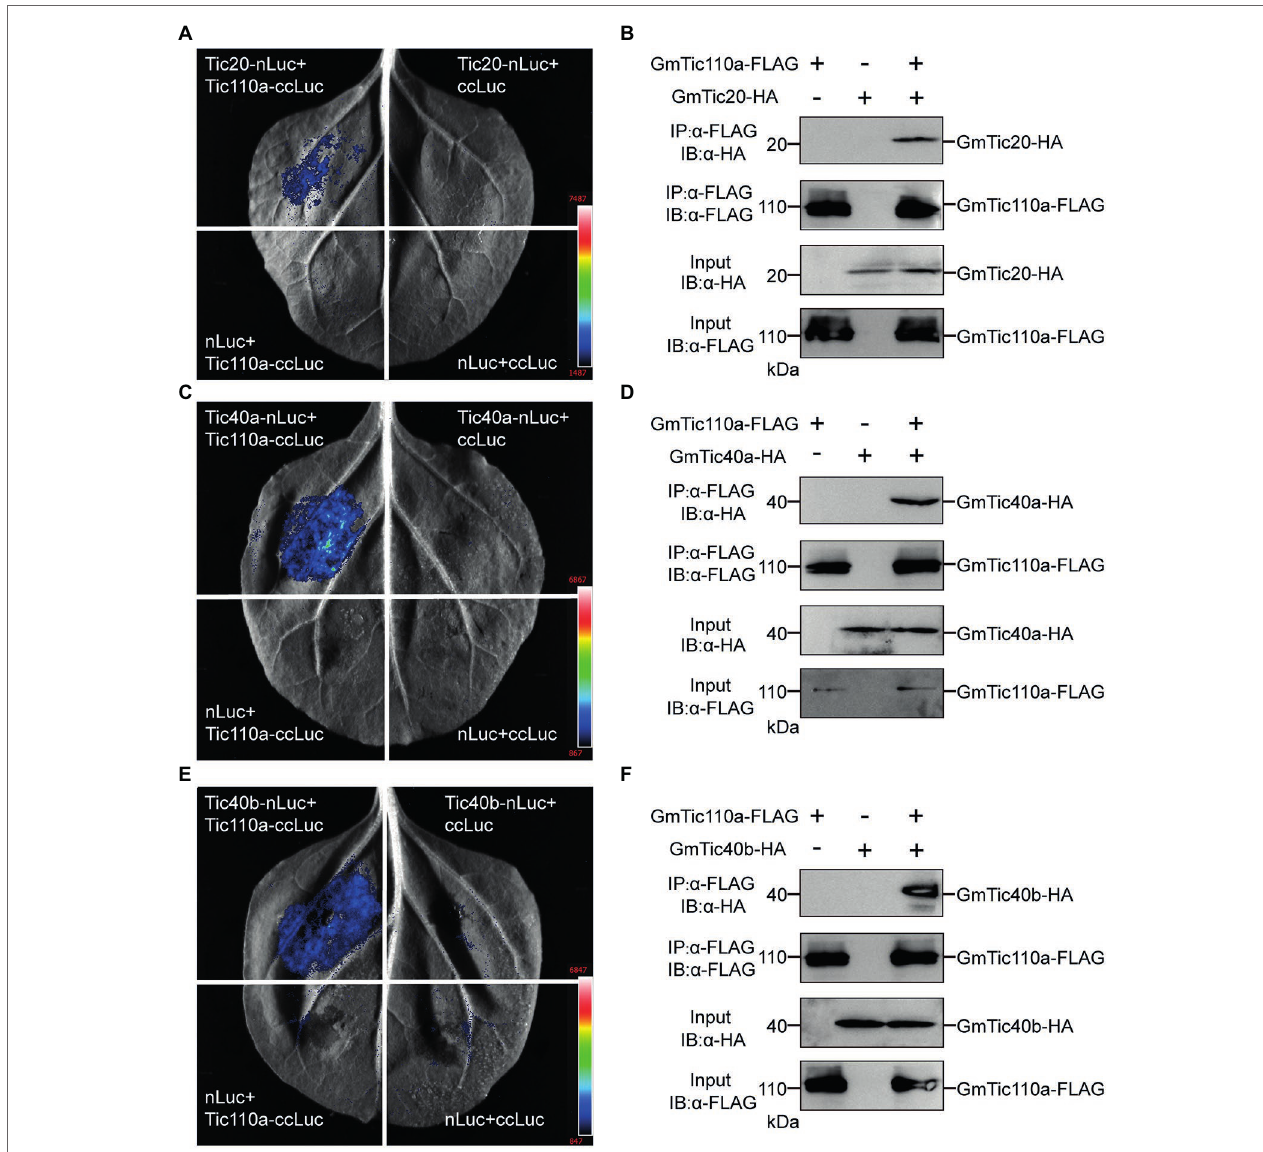
FIGURE 6 | GmTic110a interacts with GmTic20, GmTic40a, and GmTic40b. (A,C,E) Luciferase complementation assay showing that GmTic110a interacts with GmTic20, GmTic40a, and GmTic40b in Nicotiana benthamiana . Luciferase activity was detected 3 days after injection. (B,D,F) Interactions with GmTic20, GmTic40a, and GmTic40b in N. benthamiana according to a Co-IP assay. Immunoblots of the total protein extracts (20% input) and the immunoprecipitation product were performed using an anti-HA antibody (a-HA) or an anti-FLAG antibody (a-FLAG),